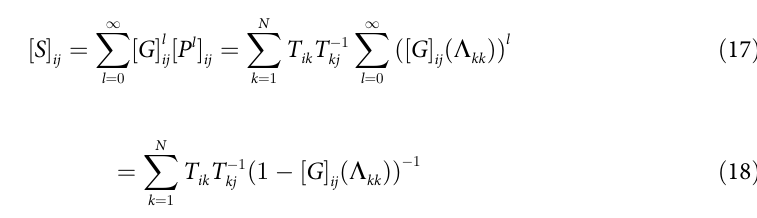
PLOS ONE | https://doi.org/10.1371/journal.pone.0221172 August 15,